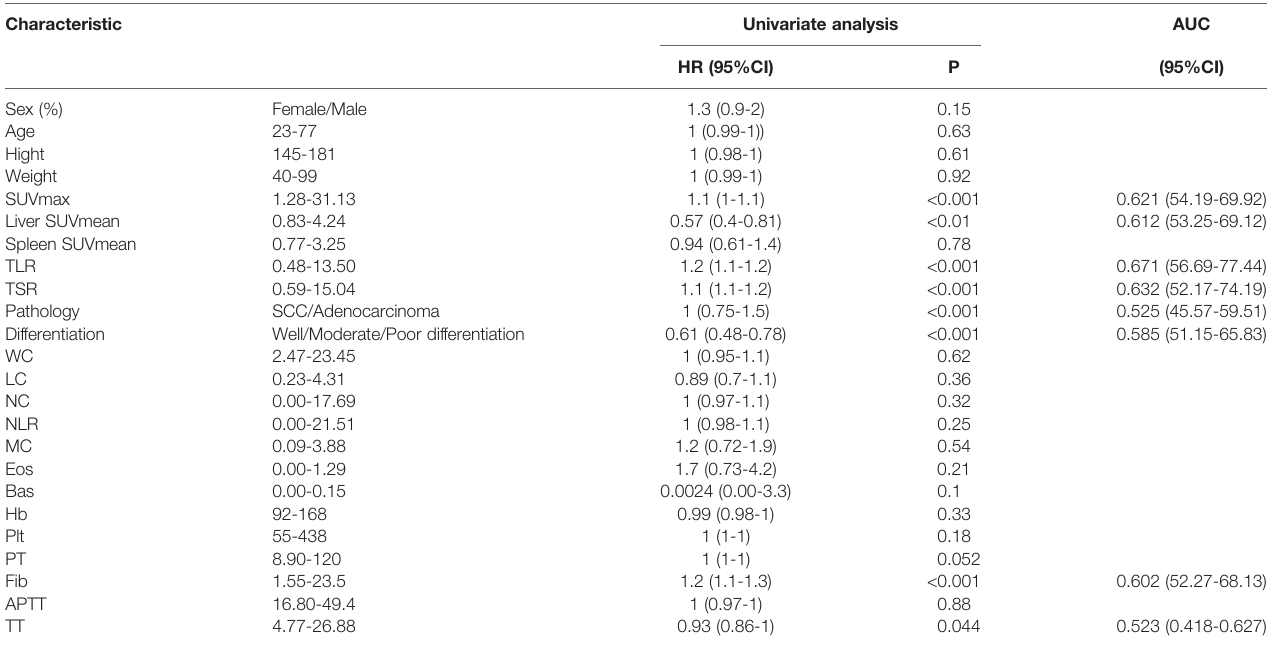
TABLE 2 | Univariate regression analysis of survival performed for all basic characteristics.